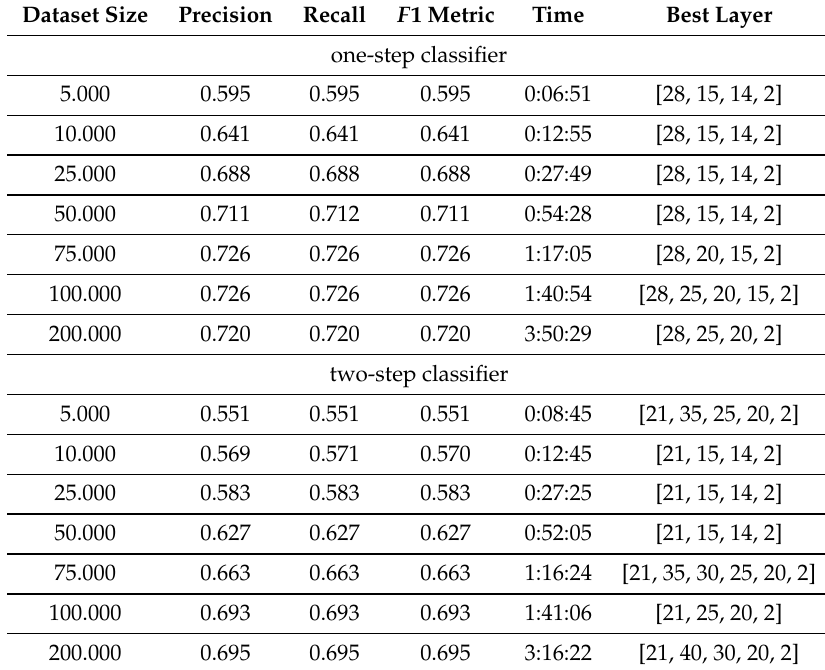
Table 5. Multilayer